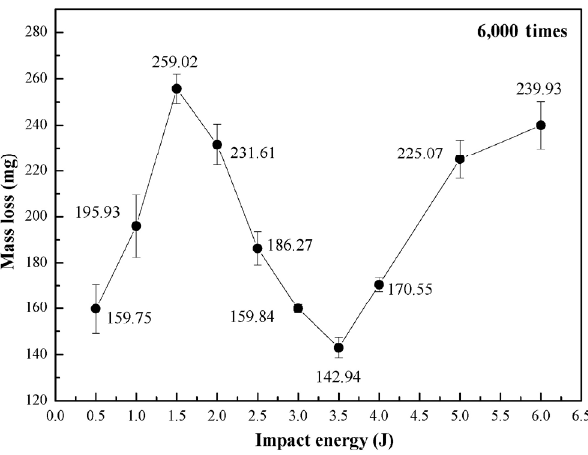
Fig. 2 The mass loss of the MMAS under different impact energies for 6,000